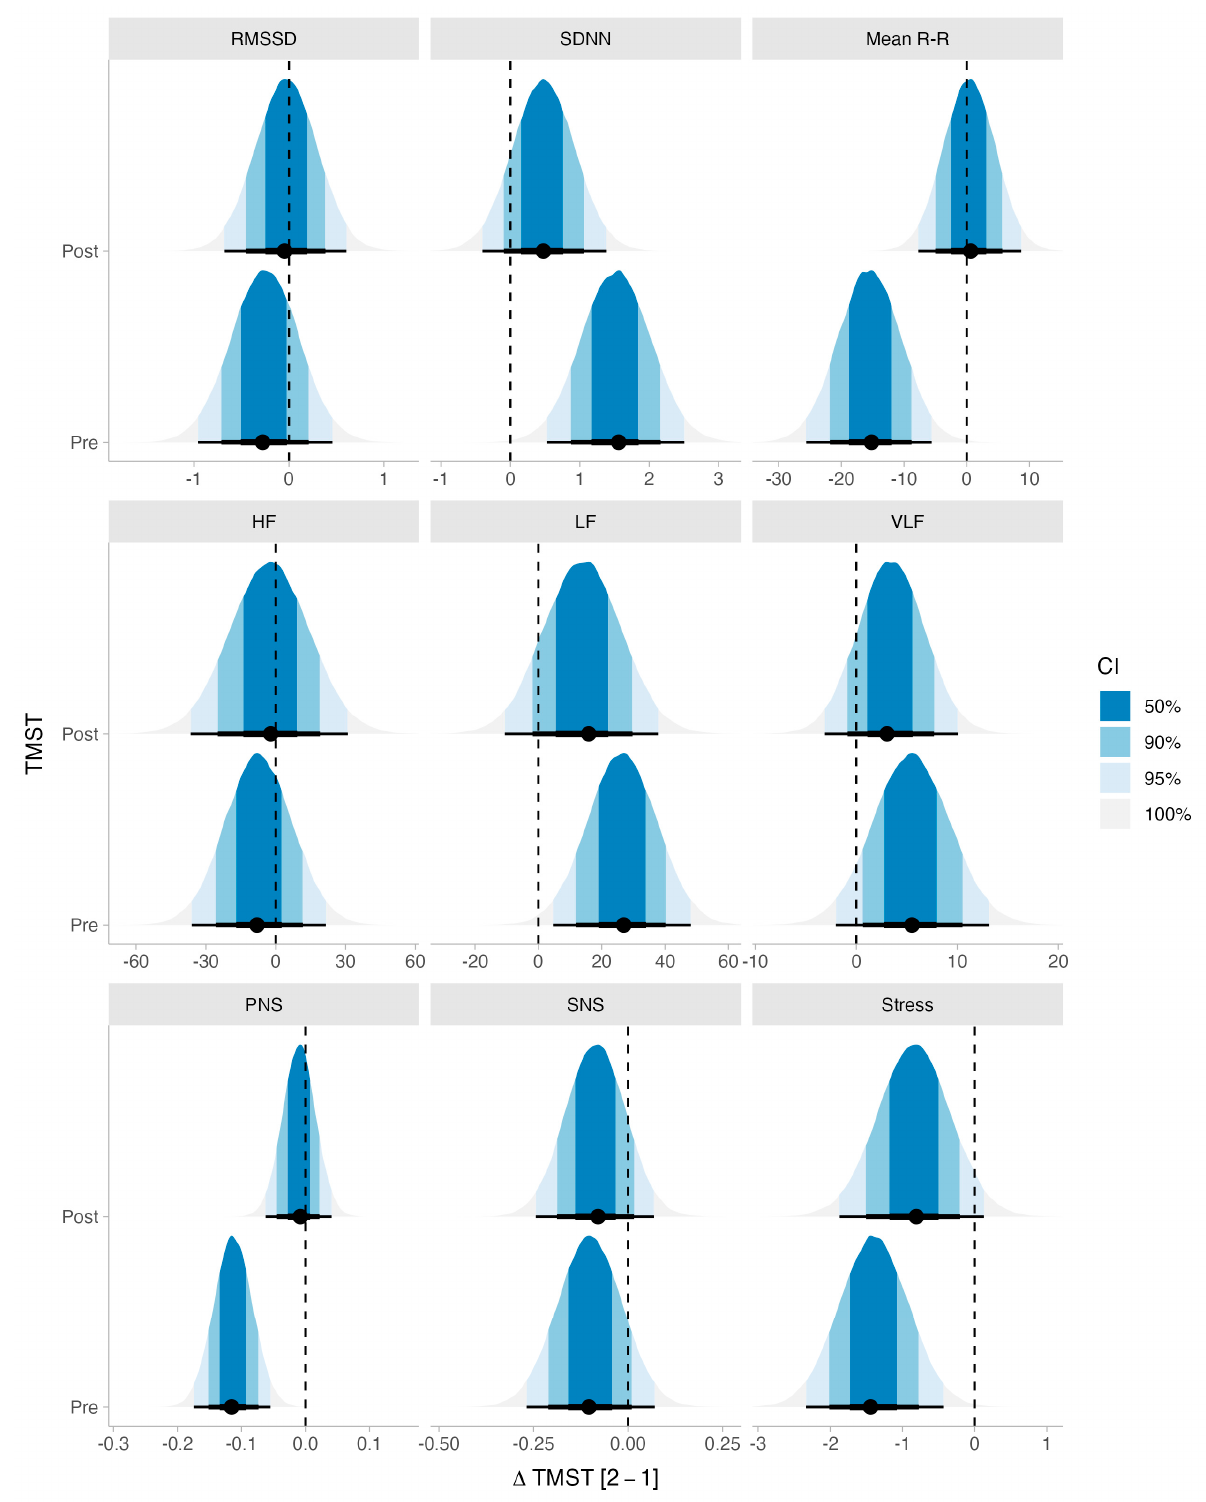
Figure 1. Posterior distributions for each HRV measure for each difference between 2-min step test pre- and post-assessments ( ∆ HRV-TMST [2-1]). This represents the uncertainty around each estimate and the probability associated with it.